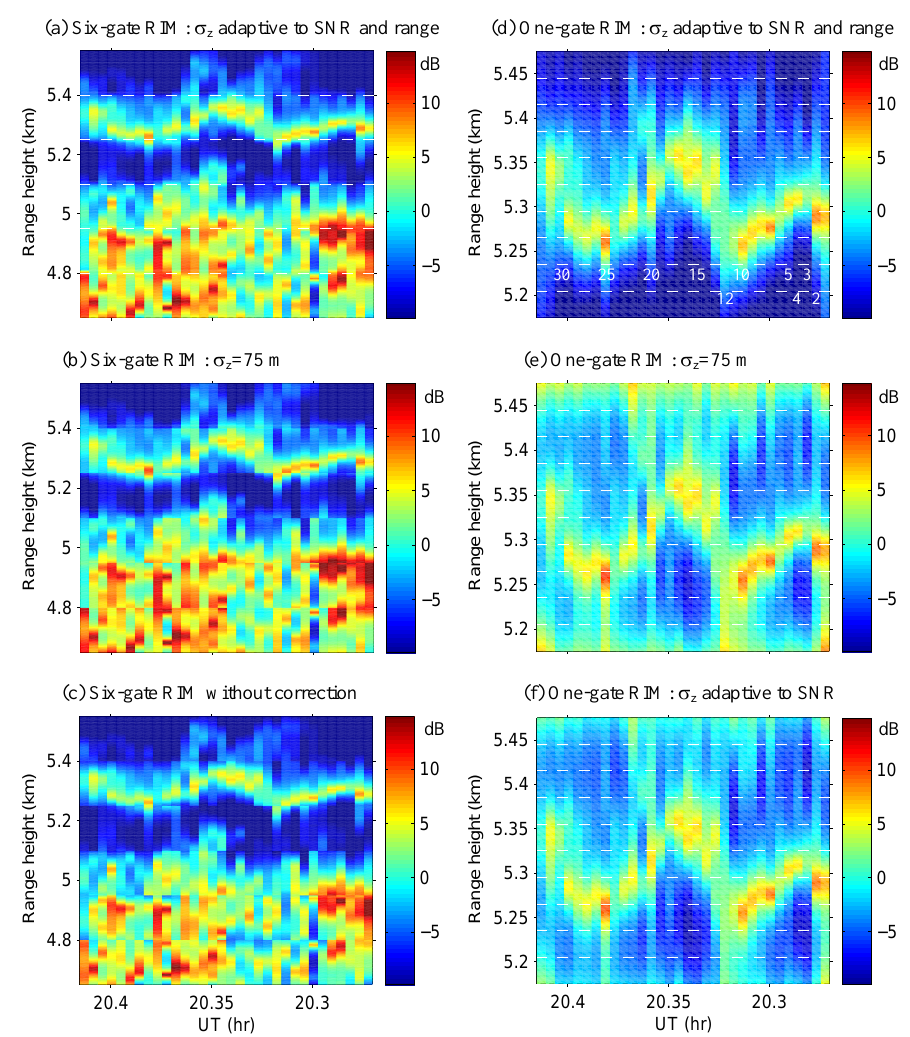
Figure 2. Range imaging of a wavy layer, observed by the MUR. The range step of imaging is 1m, and time resolution is about 16s. The time starts from the right side of the abscissa. (a) Range imaging for six sampling gates with range centers at 4.725, 4.875, 5.025, 5.175, 5.325, and 5.475km. Imaging process of each gate is from − 75 to 75m with respect to the range center of the sampling gate, and SNR- and range-dependent RWF is used in correction of brightness value. (b) and (c) are similar to (a) but with a commonly defined RWF in (b) and without correction of RWF in (c) . The three panels of (d) , (e) and (f) are the imaging results for the sampling gate centered at 5.325km, but the imaging process is from − 150 to 150m with respect to the range center of the sampling gate and uses different RWFs in correction of brightness value. The numbers given in the panel (d) denote the time slots.